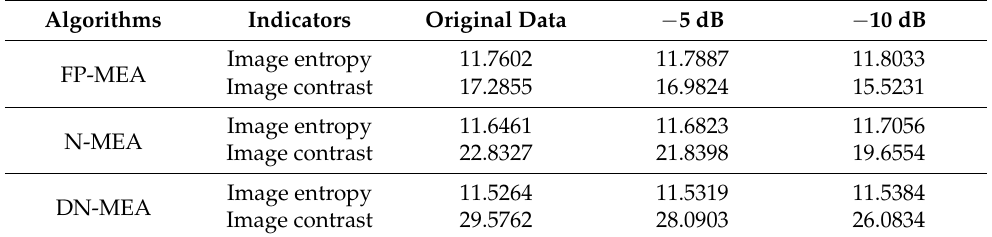
Table 4. Image entropy and image contrast of imaging results in Figures 6 and 8. Algorithms